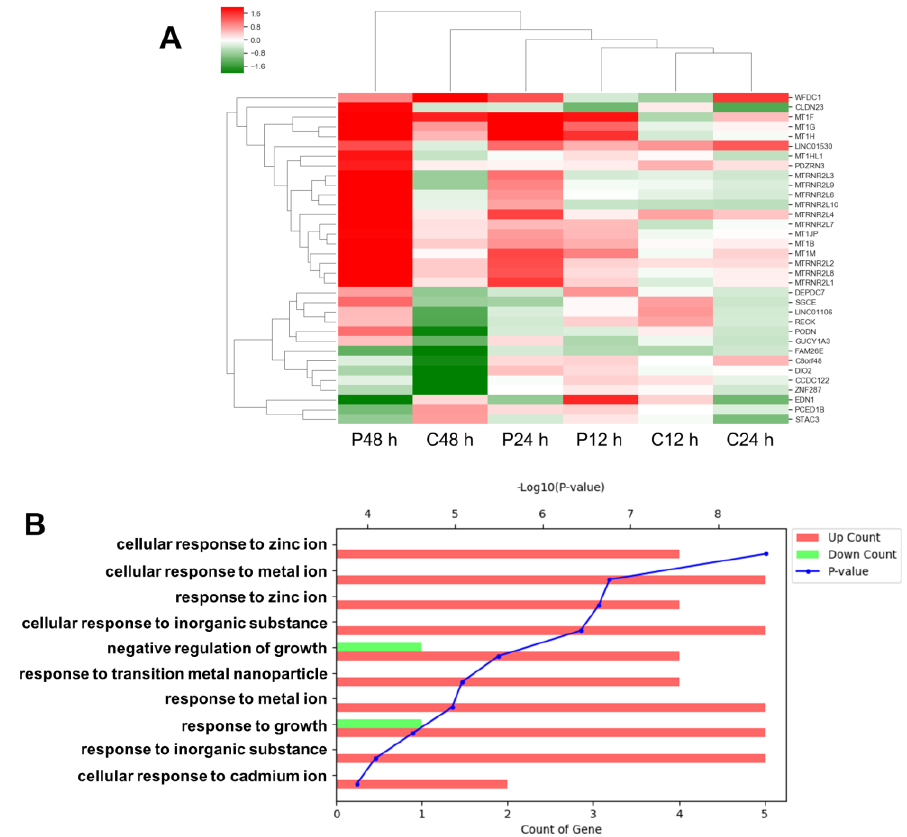
Figure 2. Effects of PHMG and CMIT on the gene expression of HPAEpiCs. ( A ) Heatmap of selected genes (more than 3-fold; p < 0.05) in HPAEpiCs after exposure to 2 µg/mL of PHMG or CMIT. ( B ) Gene ontology enrichment analysis of the top 10 biological processes for selected genes.